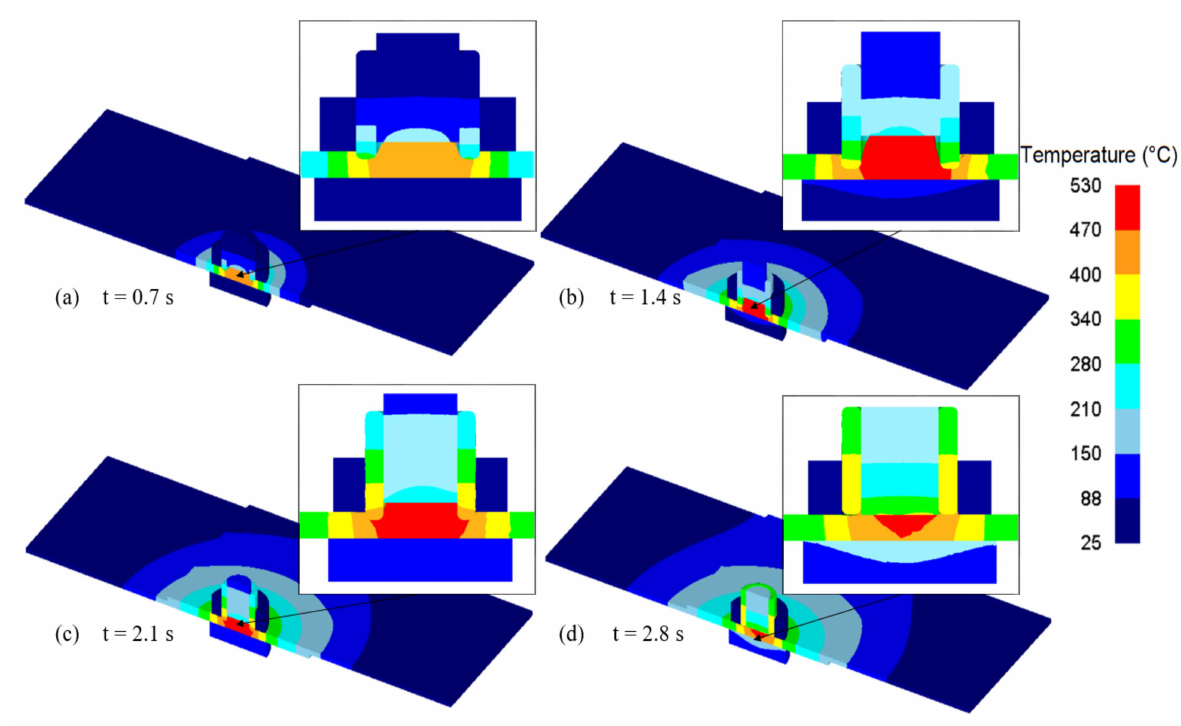
Figure 7. Temperature distribution during plunging ( a , b ) and refilling stages ( c , d ) of refill FSSW. ( a ) 0.7 s; ( b ) 1.4 s; ( c ) 2.1 s; ( d ) 2.8